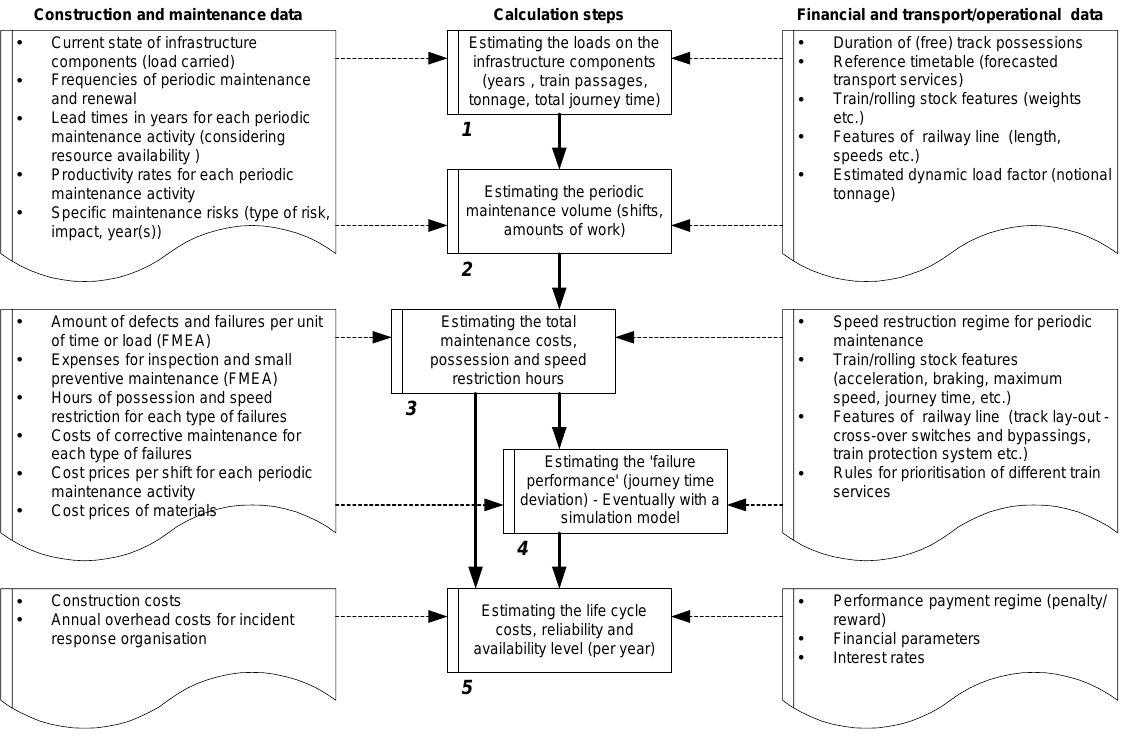
Figure 3. Structure of the ‘ Life Cycle Cost Plan’ decision support